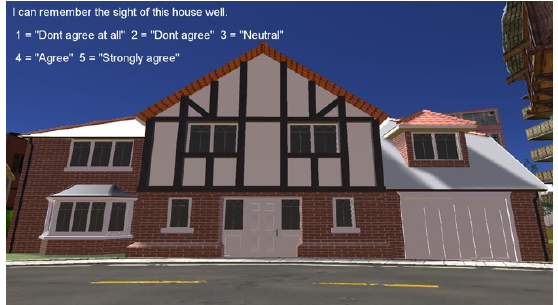
Figure 5: Design of the task. Two statements had to be rated for each picture. Here the familiarity rating is shown. After the re- sponse the same picture is shown again with the navigation ques- tion.